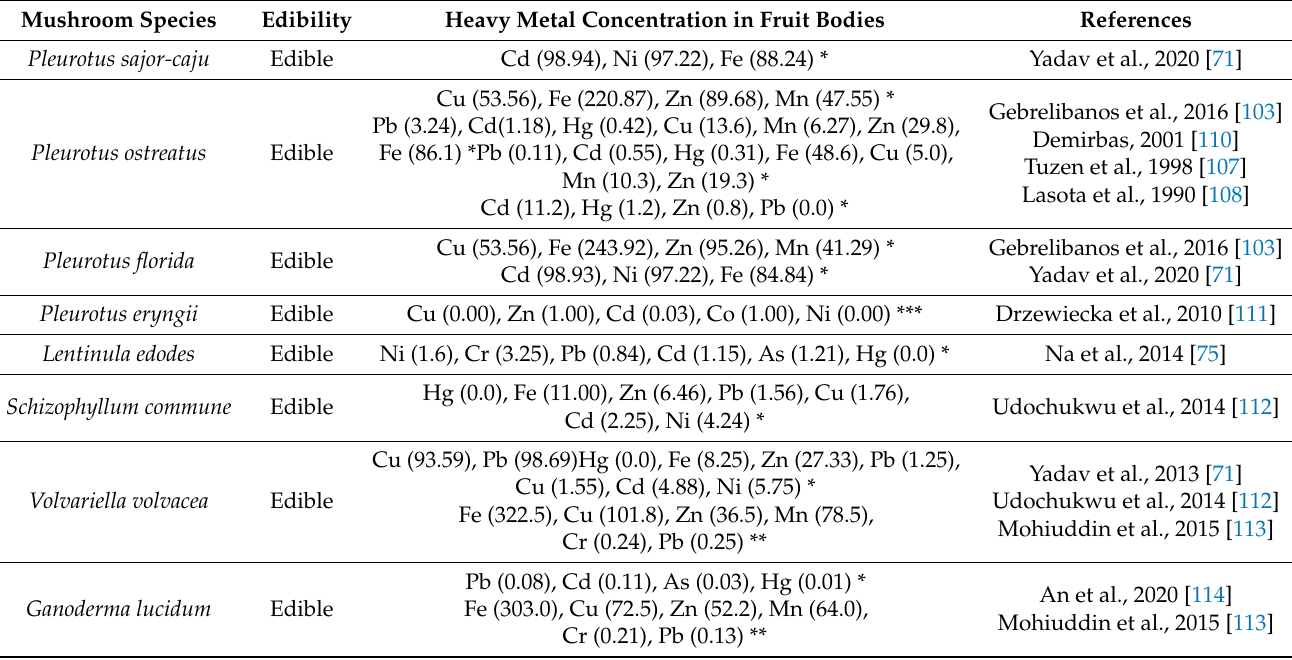
Table 4. Absorption of heavy metals in mushroom fruit bodies.